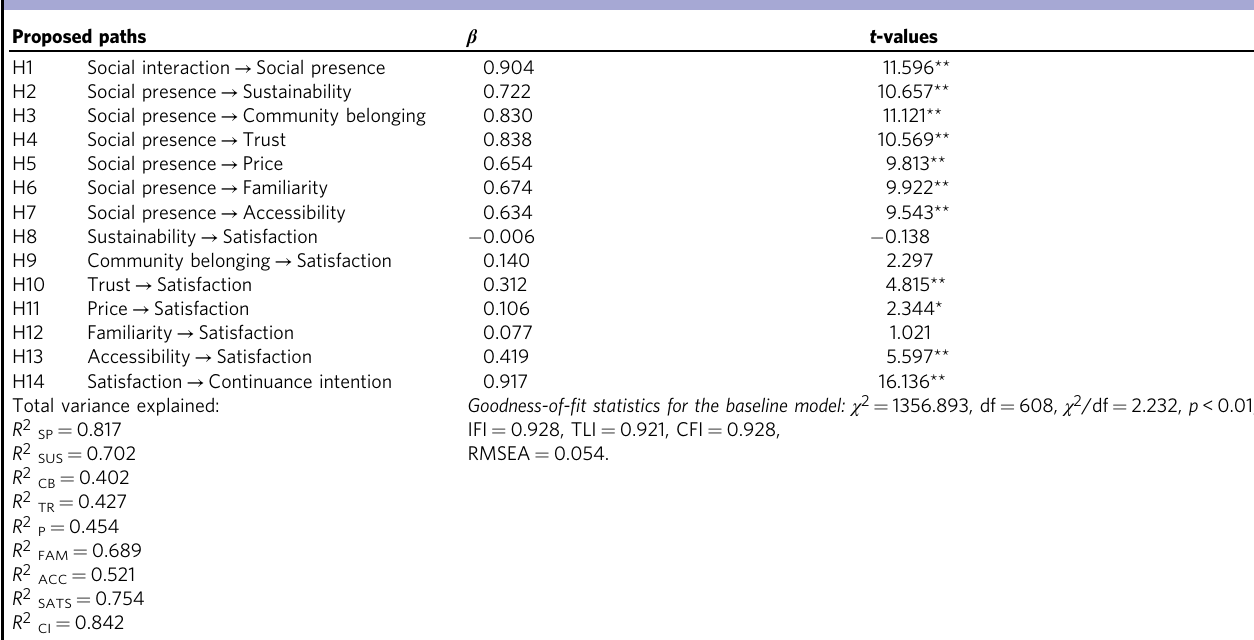
Table 2 The structural model